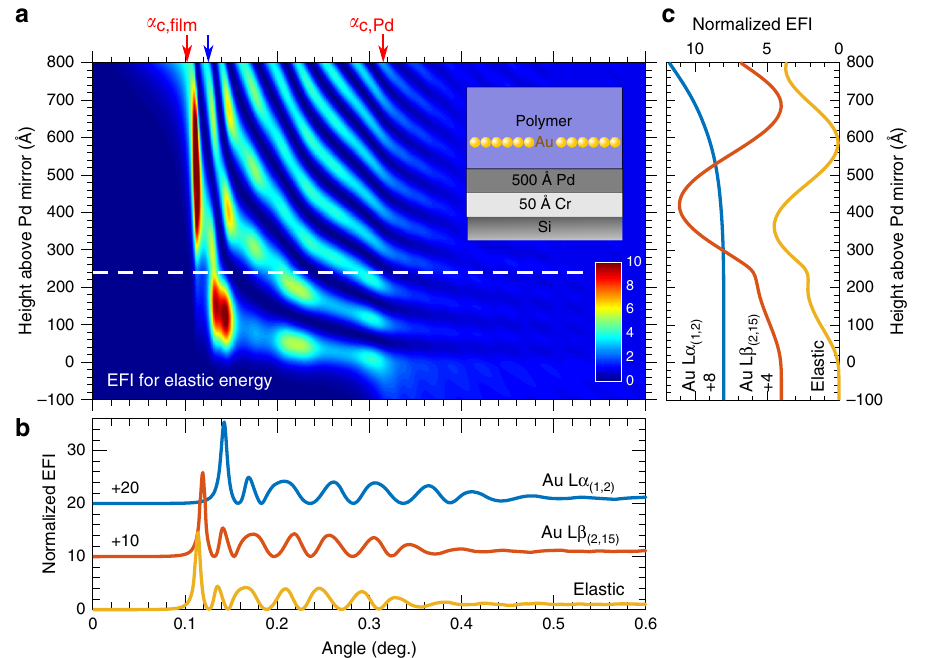
Fig. 2 Electric fi eld intensity (EFI) distribution. a EFI for the elastic energy (12.11 keV) as a function of grazing angle and height above the Pd mirror for the LH sample whose the gold monolayer is ~250 Å above the mirror (white dashed line). Parameters for the calculation are from the reconstructed XWFH before the thermal annealing (details described in the text). Two red arrows indicate the critical angles for total-external re fl ection of the polymer fi lm ( α c, fl im | e = 0.102°) and the Pd mirror ( α c,Pd | e = 0.317°), respectively, at the elastic energy. Inset illustrates the layers of the sandwiched fi lm. b Line pro fi les of the EFI at the gold monolayer height for three energies: elastic, gold L α (1,2), and L β (2,15) . c Line pro fi les of the normalized EFI at a grazing angle of 0.125° (indicated by the blue arrow in a ) for the three